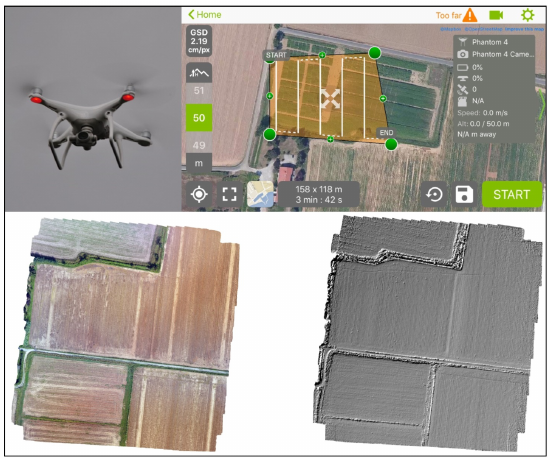
Figure 7. Elements of Drone Survey. From top left clockwise – Drone Phantom 4 DJI, flight plan with parameters, DSM hillshade and orthophoto 2cm GSD.